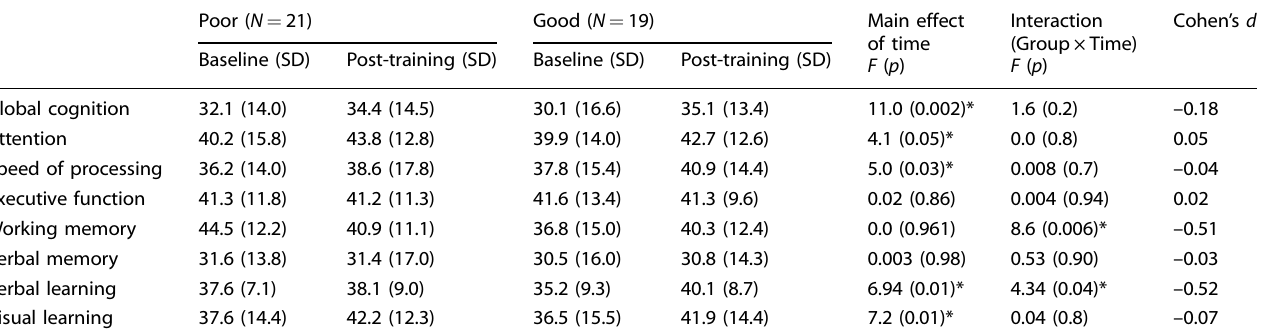
Table 2. Cognitive measures at baseline and at the post-training timepoint in SCZ patients with poor and good functional outcome.